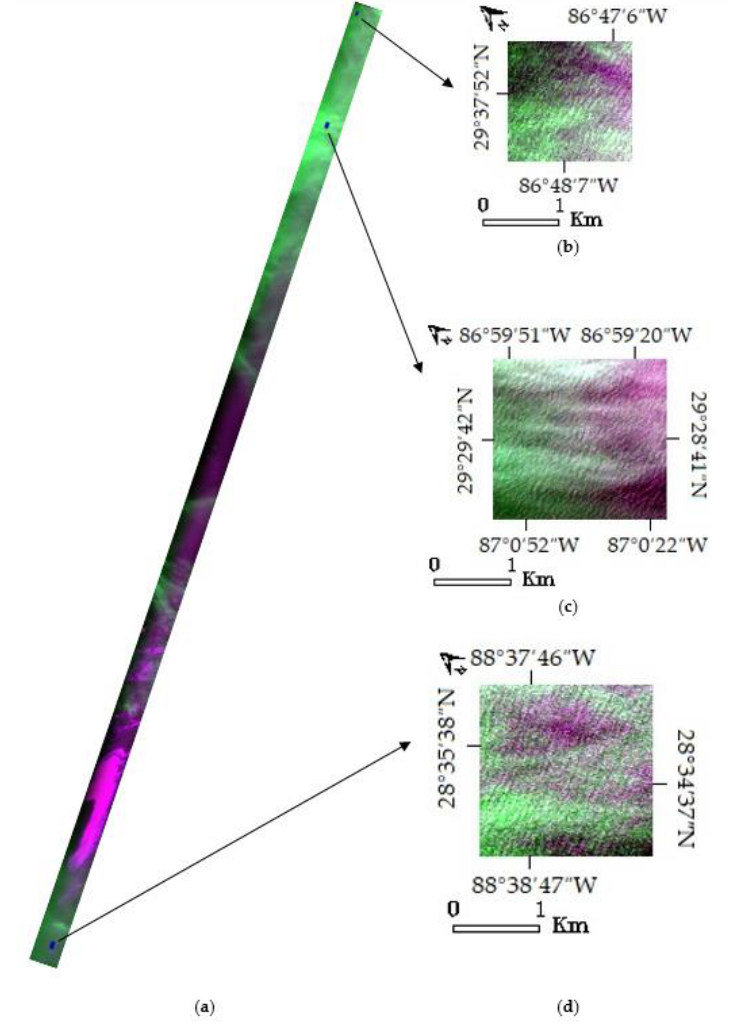
Figure 4. ( a ) False color RGB images (R: 1662 nm, G: 1363 nm, B: 1005 nm) of the oil spill in the Gulf of Mexico recorded by AVI RIS on 13 May 2010. ( b – d ) are the false color RGB images (R: 1662 nm, G: 1363 nm, B: 1005 nm) of the oil spill over the blue boxes in ( a ).